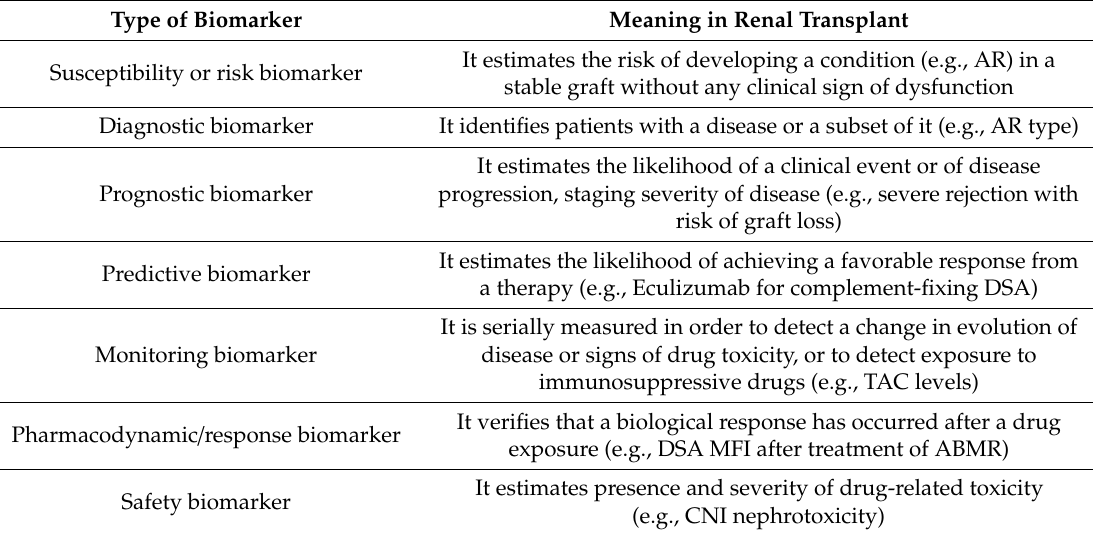
Table 1. Biomarkers categories and their meaning in renal